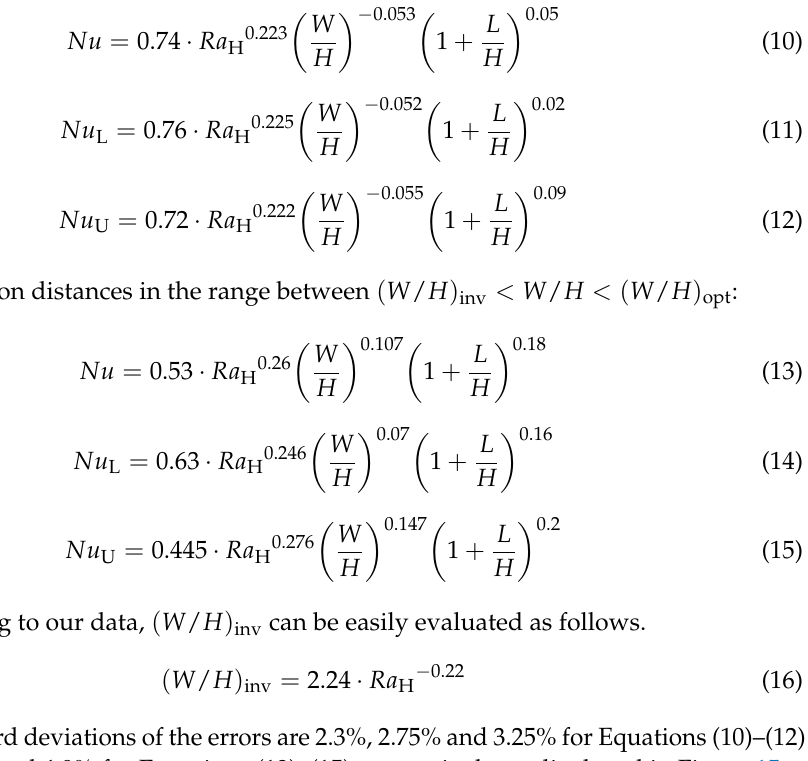
The standard deviations of the errors are 2.3%, 2.75% and 3.25% for Equations (10)–(12) and 3.7%, 3.2% and 4.9% for Equations (13)–(15), respectively, as displayed in Figure